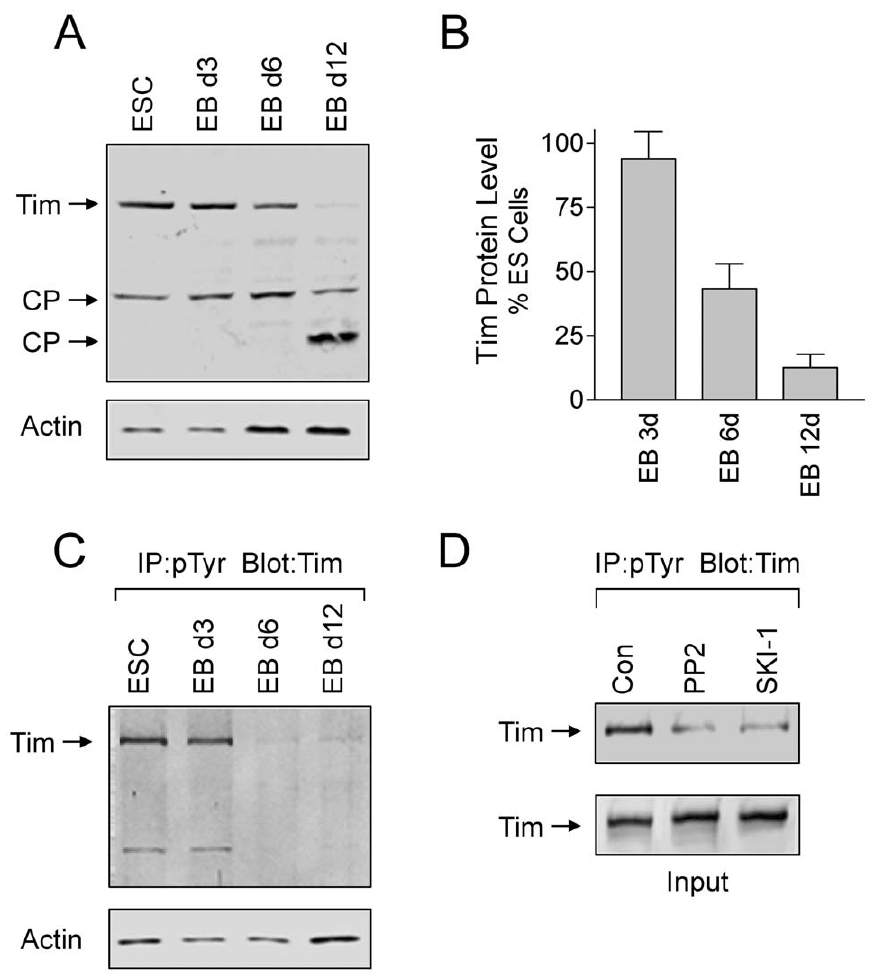
Figure 9. Changes in Tim protein levels and tyrosine phosphorylation during EB formation. A and B , Tim protein levels diminish during EB formation. Lysates were prepared from self-renewing ES cells (ESC) and 3, 6, and 12 day EBs, and immunoblotted for Tim and actin protein levels. Full length Tim as well as two possible cleavage products (CP) are indicated by the arrows. Relative band intensities for full-length Tim and actin were determined using ImageJ from four independent experiments and Tim:actin ratios were calculated. The results were normalized to ratios obtained from control ES cells, and are presented in the bargraph as the mean 6 S.E.M. The level of Tim was significantly reduced after 6 and 12 days of EB formation (p # 0.01). C , Tyrosine phosphorylation of endogenous Tim in ES cells and EBs. Lysates were prepared from self-renewing ES cells and 3, 6, and 12 day EBs, and tyrosine-phosphorylated proteins were immunoprecipitated from protein aliquots and analyzed for Tim by immunoblotting (top panel). Actin blots were performed to verify equivalent levels of input protein for the immunoprecipitation (lower panel). This experiments was repeated three times with comparable results; a representative example is shown. D , Inhibition of Tim tyrosine phosphorylation in ES cells by Src- family kinase inhibitors. ES cells were incubated with the Src-family kinase inhibitors PP2 and SKI-1 [12] at 10 m M for 16 h. Tyrosine-phosphorylated proteins were immunoprecipitated and analyzed for the presence of Tim by immunoblotting (top panel). Tim blots (lower panel) verified equivalent levels of Tim in each lysate prior to